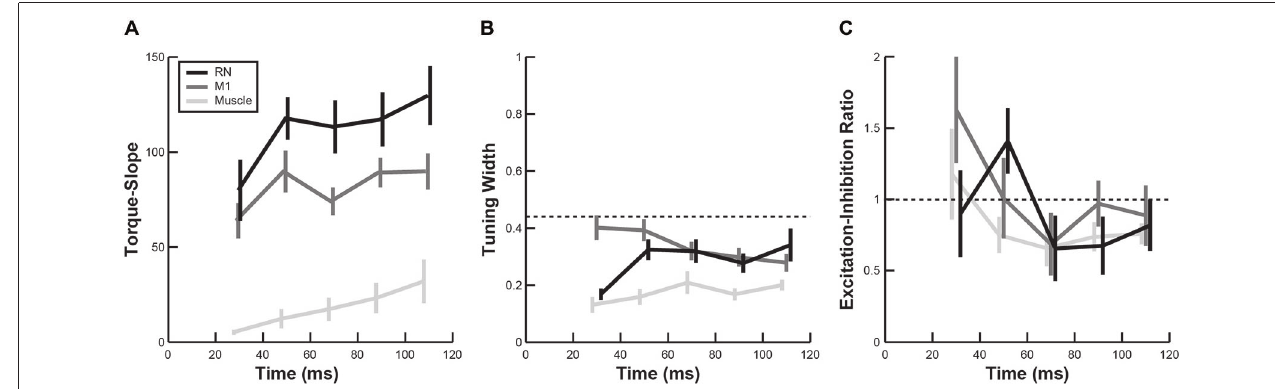
FIGURE 7 | Temporal evolution of perturbation-related activity . (A–C) Plots show changes in torque-slope (A) , tuning width (B) and activation-inhibition ratio (C) of RN neurons (black), M1 neurons (dark gray) and upper-limb muscles (light gray) during the first 120 ms after perturbation onset (mean ±